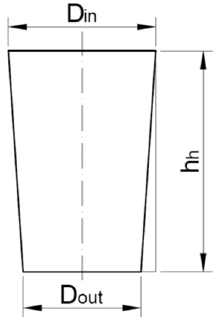
Figure 4. Measurement of the diameter accuracy and the taper angle ( tap α ).